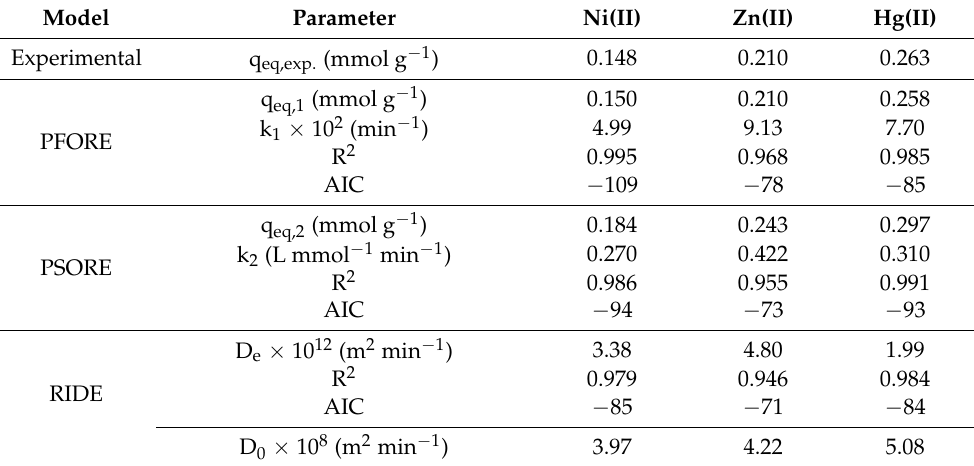
Table 1. Ni(II), Zn(II) and Hg(II) uptake kinetics using G@MChs for single-component solutions— parameters of the models.